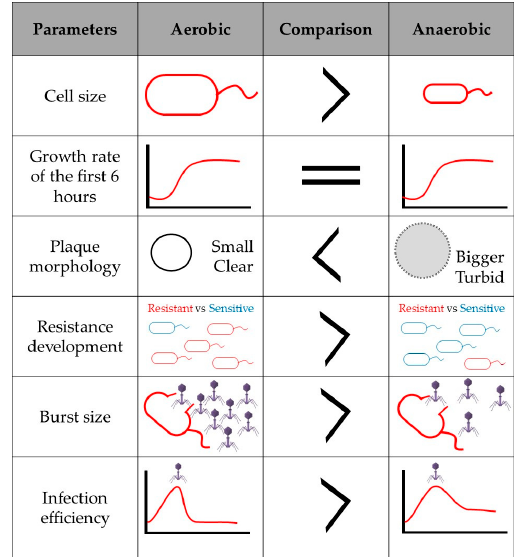
Figure 2. Infection and viral replication of Salmonella s25pp bacteriophage ϕ San23 in aerobiosis and anaerobiosis.